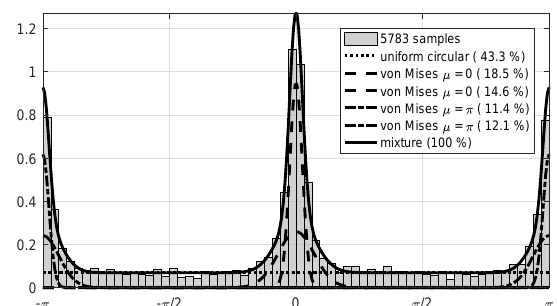
Figure 3. Extracted building outlines for the first index image.